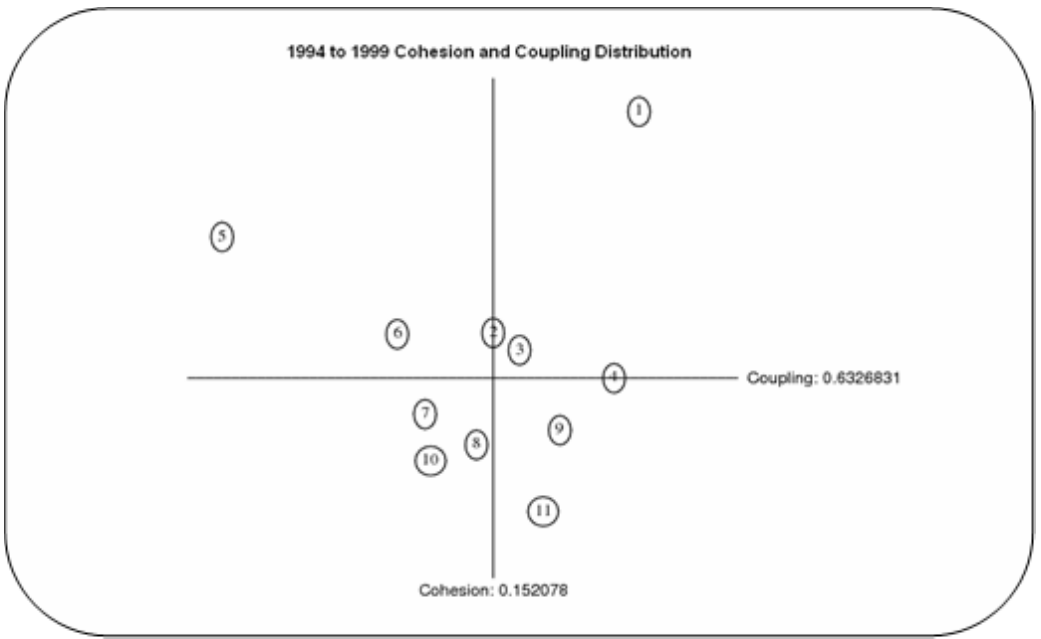
Figure 6 . Cohesion and coupling graph (1994 to